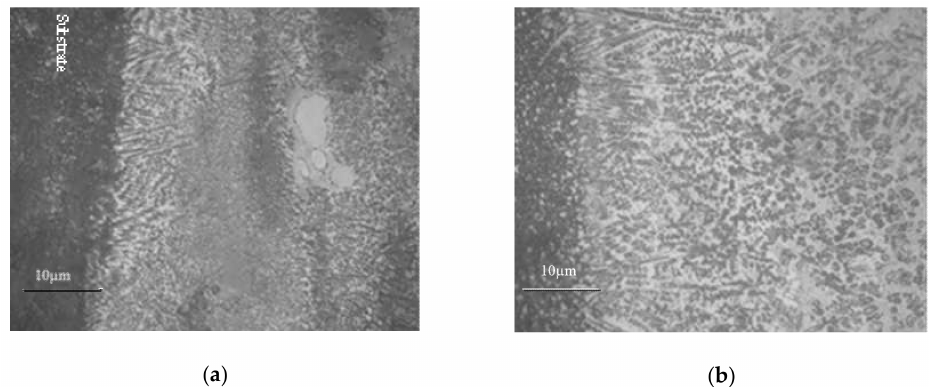
Figure 6. Microstructures of coating 2 and coating 3. ( a ) Coating 2 (annealing at 300 ◦ C for 1 h), ( b ) coating 3 (preheated to 250 ◦